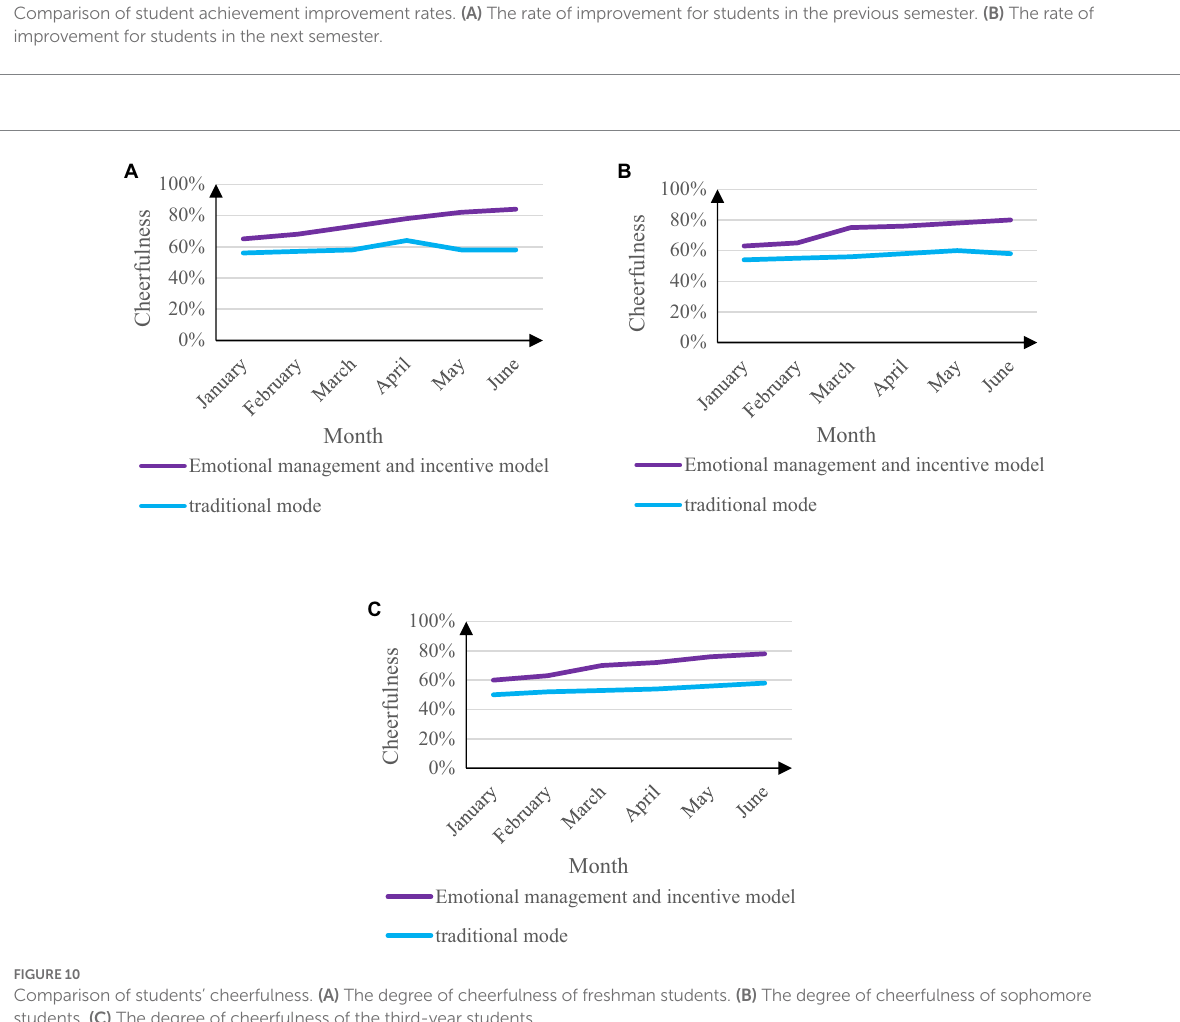
experiment is carried out for 6 months, and the data on the cheerfulness of the students are investigated once a month shown in Figure